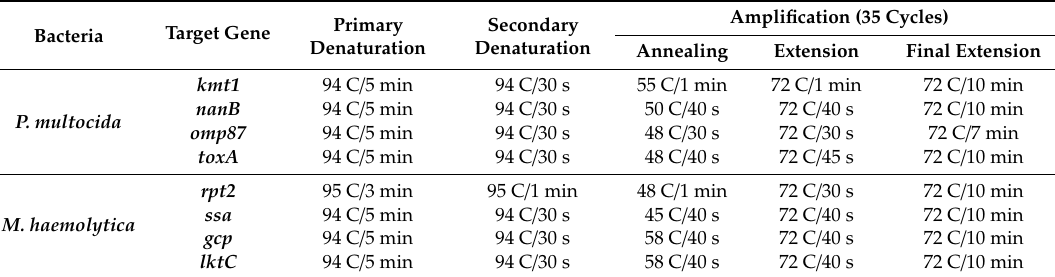
Table 3. Cycling conditions of the di ff erent primers during